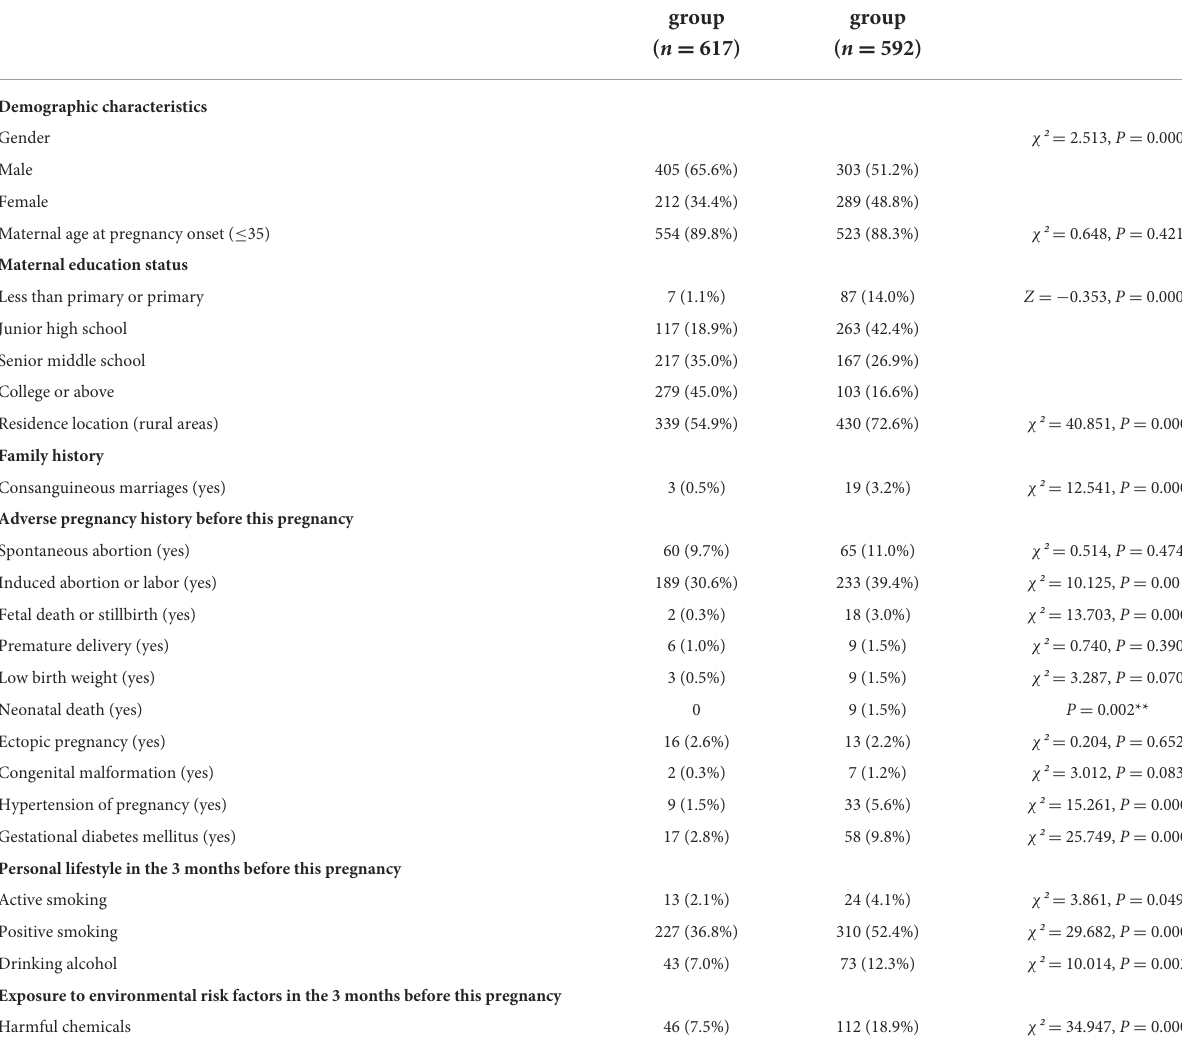
illustrated comparisons of baseline characteristics across two groups, and Supplementary Table S1 stated comparisons of baseline characteristics based on the use status of folic